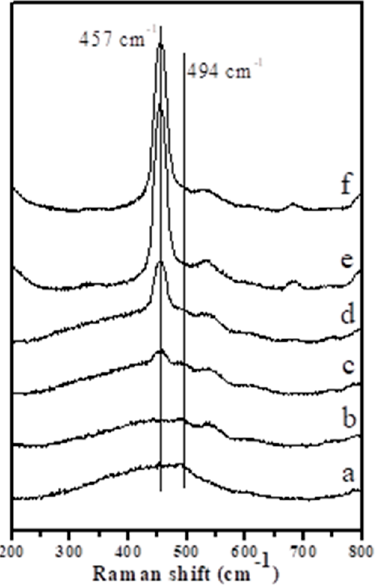
Figure 9. UV-Raman spectra of S–Si–SOD zeolites crystallized at 200 °C for ( a ) 0, ( b ) 8, ( c ) 12, ( d ) 14, ( e ) 16, and ( f ) 24, respectively.